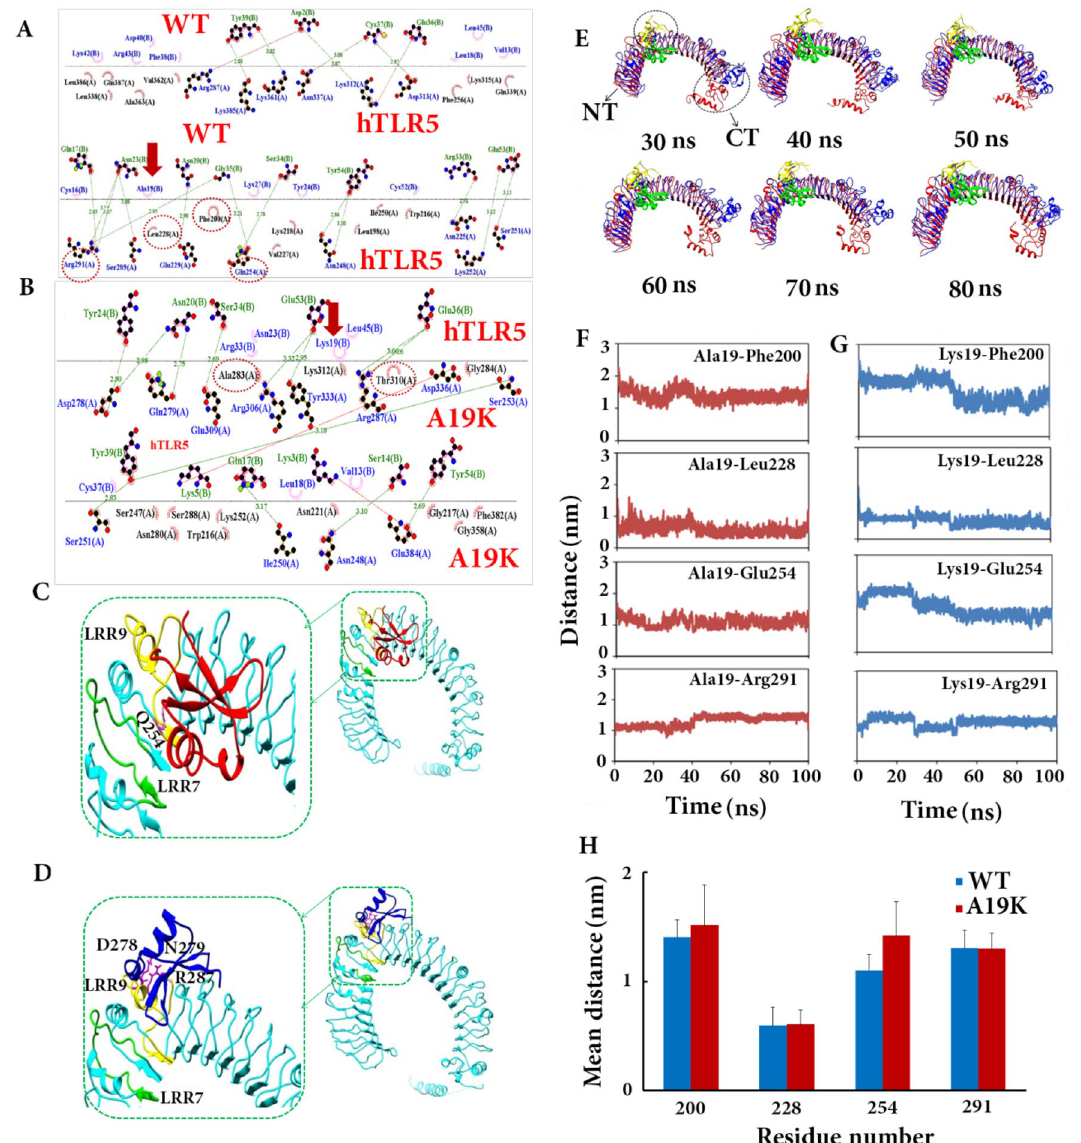
Figure 5. Intermolecular contact analysis of Brazzein and hTLR5 displaying various non-bonded interactions. ( A ) Contact analysis of hTLR5-WT complex obtained after MD. ( B ) Contact analysis of hTLR5-p.A19K complex obtained after MD. The hydrogen bonds are shown in dashed lines while the interacting residues are shown in ball and stick representation. The other hydrophobic contacts are shown in semi-circles. Dotted circle shows all residue which interact with Ala 19 in WT-type and p.A19K as hotspot mutation in Brazzein. ( C ) The superimpose of WT of Brazzein (red color) and hTLR5 (cyan color). LRR7 and LRR9 domains of hTLR5 have been shown in green and yellow colors, respectively which Q254 of Brazzein is located in the LRR9 domain of hTL5. ( D ) The superimpose of p.A19K mutant of Brazzein (blue color) and hTLR5 (cyan color). LRR7 and LRR9 domains of hTLR5 have been shown in green and yellow colors, respectively which D278, N279, and R287 of Brazzein are located in the LRR9 domain of hTLR5. ( E ) The WT structure (green color) superimposed on either the p.A19K mutant (yellow color) of Brazzein in complex with hTLR5 (WT in blue and mutant in red colors) to compare the level of fluctuation in the LRR and CT domains during the simulation time. The p.A19K mutant showed a clear structural change from 30 to 80 ns. ( F , G ) Inter-atomic distance profile of the important hydrogen bond forming amino acid pairs in hTLR5-Brazzein complex using the MD trajectory. ( H ) The average distance between the interacting pairs of atoms from Brazzein and hTLR5 are summarized in bar plot. The average distance of two residues i.e. Phe 200 and Glu 254 was increased in the presence of hotspot